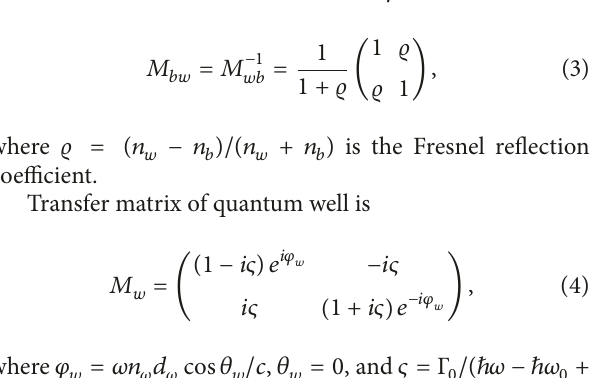
Figure 1: A schematic of 1D photonic crystal containing 𝑁 multiple quantum wells with different refractive index. 𝑑 𝐵 is the width of quantum well and 𝑑 𝐴 is width of quantum barrier which in the following will be shown with 𝑑 𝑤 and 𝑑 𝑏 ,